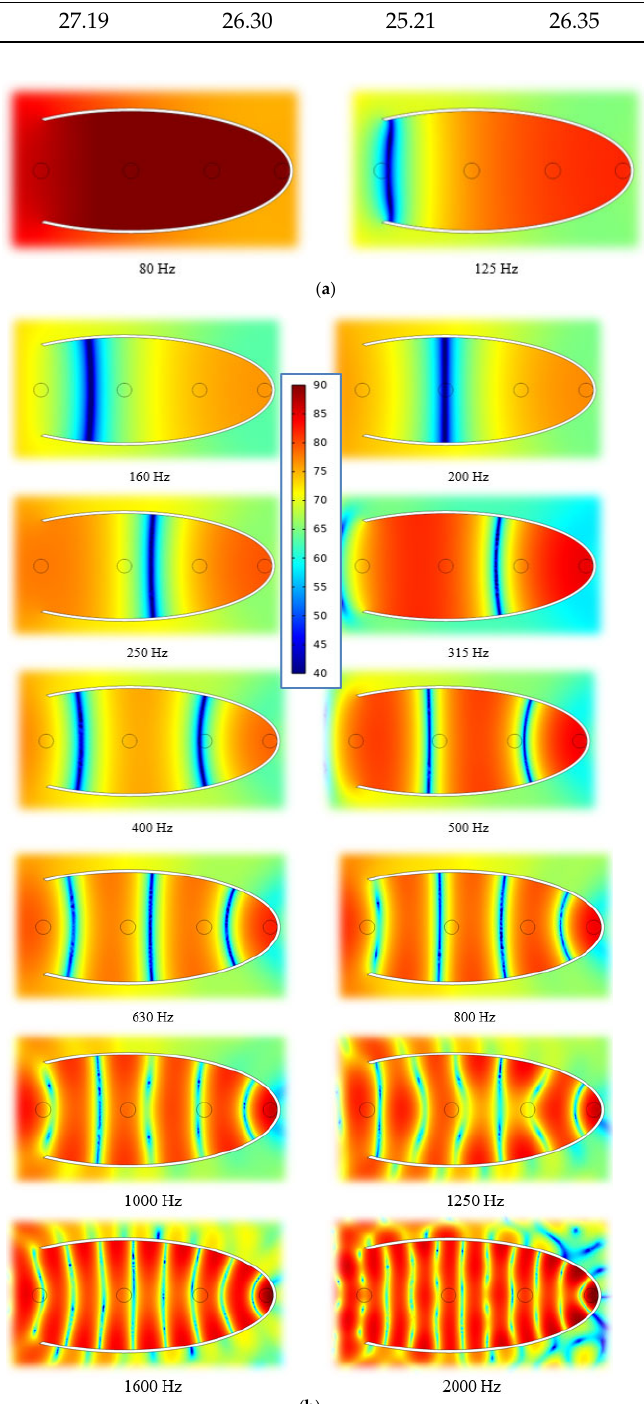
Figure 4. (a) Sound pressure level at a/b = 2.6, and octave = 80, 125Hz. (b) Sound pressure level at a/b = 2.6, and octave = 160, 200, 250, 315, 400, 500, 630, 800, 1000, 1250, 1600, and 2000 Hz.